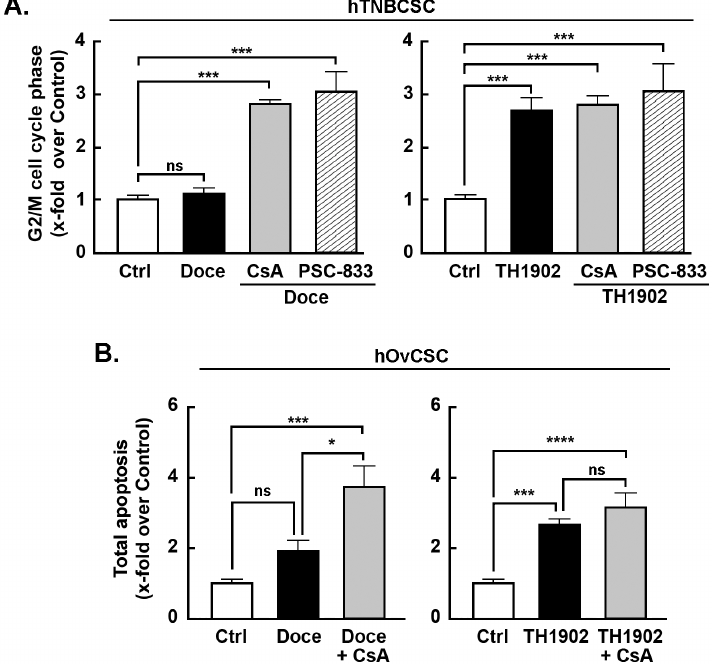
Figure 5. Effect of MDR inhibitors on cell cycle arrest following treatment with docetaxel or TH1902. MDR inhibition was performed by pre-incubating hTNBCSC cells for 30 min ± 10 µM CsA ( n = 4) or PSC-833 ( n = 3) for cell cycle experiments, or 1 µM for apoptosis assays. Cells were then incubated for 2 h with media containing the same quantities of vehicle, CsA or PSC-833 along with vehicle (Control, DMSO), 4 µM Docetaxel or 2 µM TH1902 for cell cycle experiments, or 1 µM Docet- axel and 0.5 µM TH1902 for apoptosis assays. These media were then replaced by fresh media which